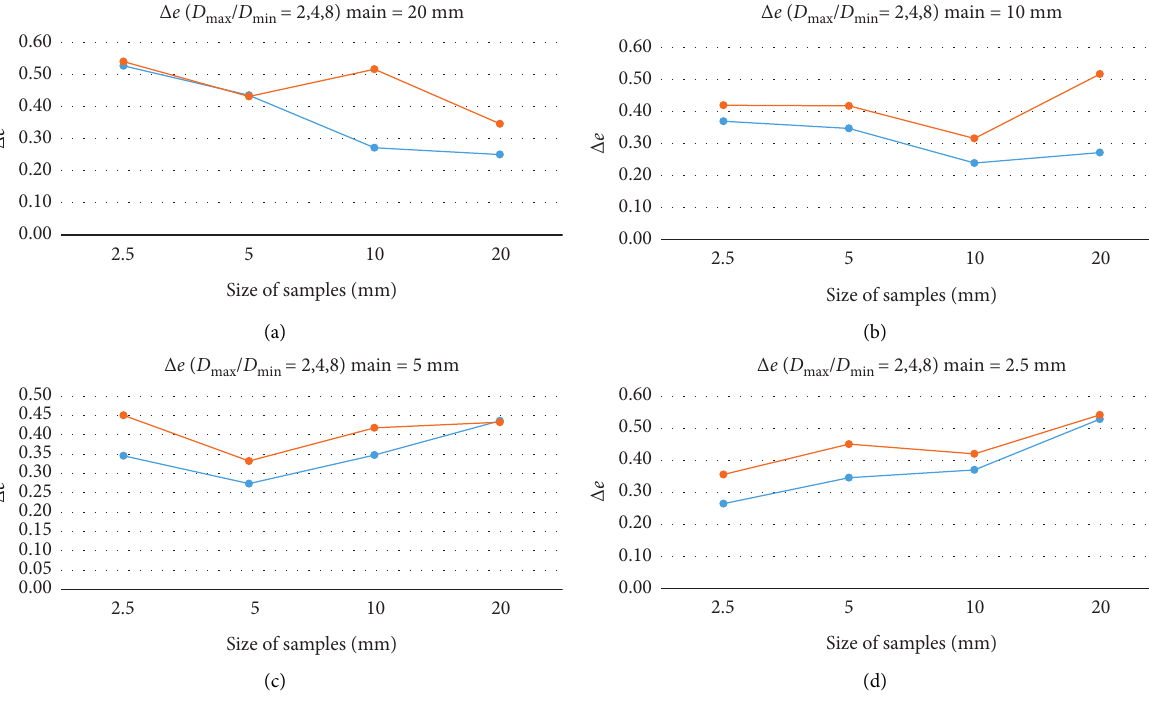
Figure 15: Difference in porosity ratio between loose and dense materials with different granulations by sudden precipitation method (weight installation of aggregates, aggregates with sizes of 2.5, 5, 10, and